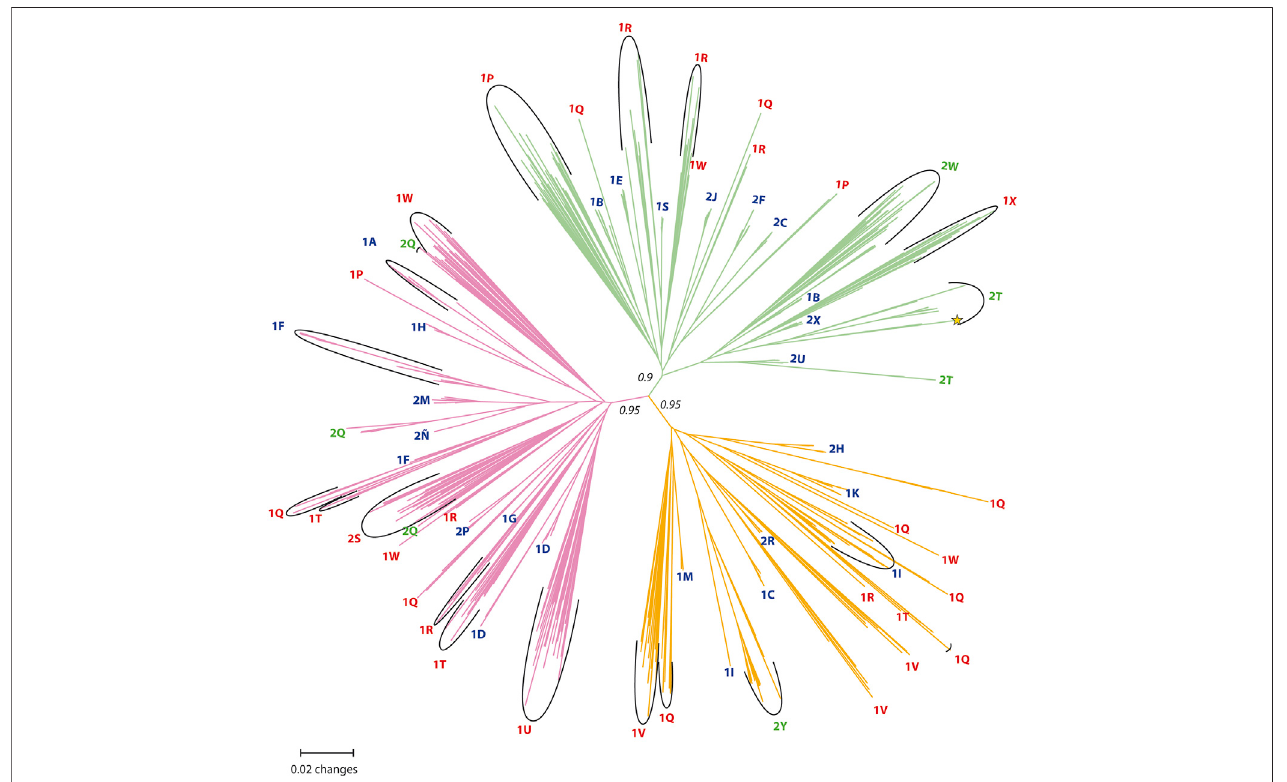
FIGURE 3 | The unrooted Neighbor-Joining (NJ) tree constructed using the Prevosti ’ s Distance Coef fi cient among the ampli fi ed fragment length polymorphisms (AFLPs)ofallthestudiedindividualsof P.intermedium withabootstrapanalysisof1,000samplesize.Thebootstrapvaluesareshownonlyforthemainbranches.Thetip labels show the respective population (red: diploid populations, blue: tetraploid populations, green: mixed-ploidy populations, *: triploid individual).